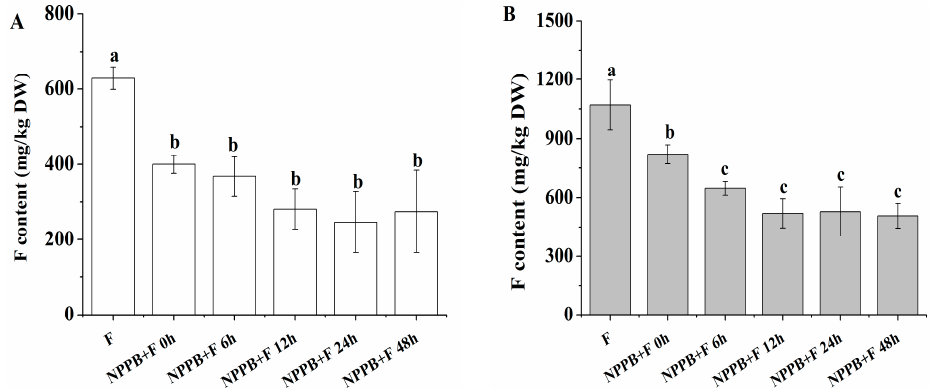
Figure 1. Effect of NPPB on F concentration in tea roots ( A ) and plants ( B ) with different pretreatment times. Data indicate mean ± SD ( n = 4). Different low case numbers above the chart bars indicate the level of significance compared with the case without the addition of NPPB at p < 0.05.